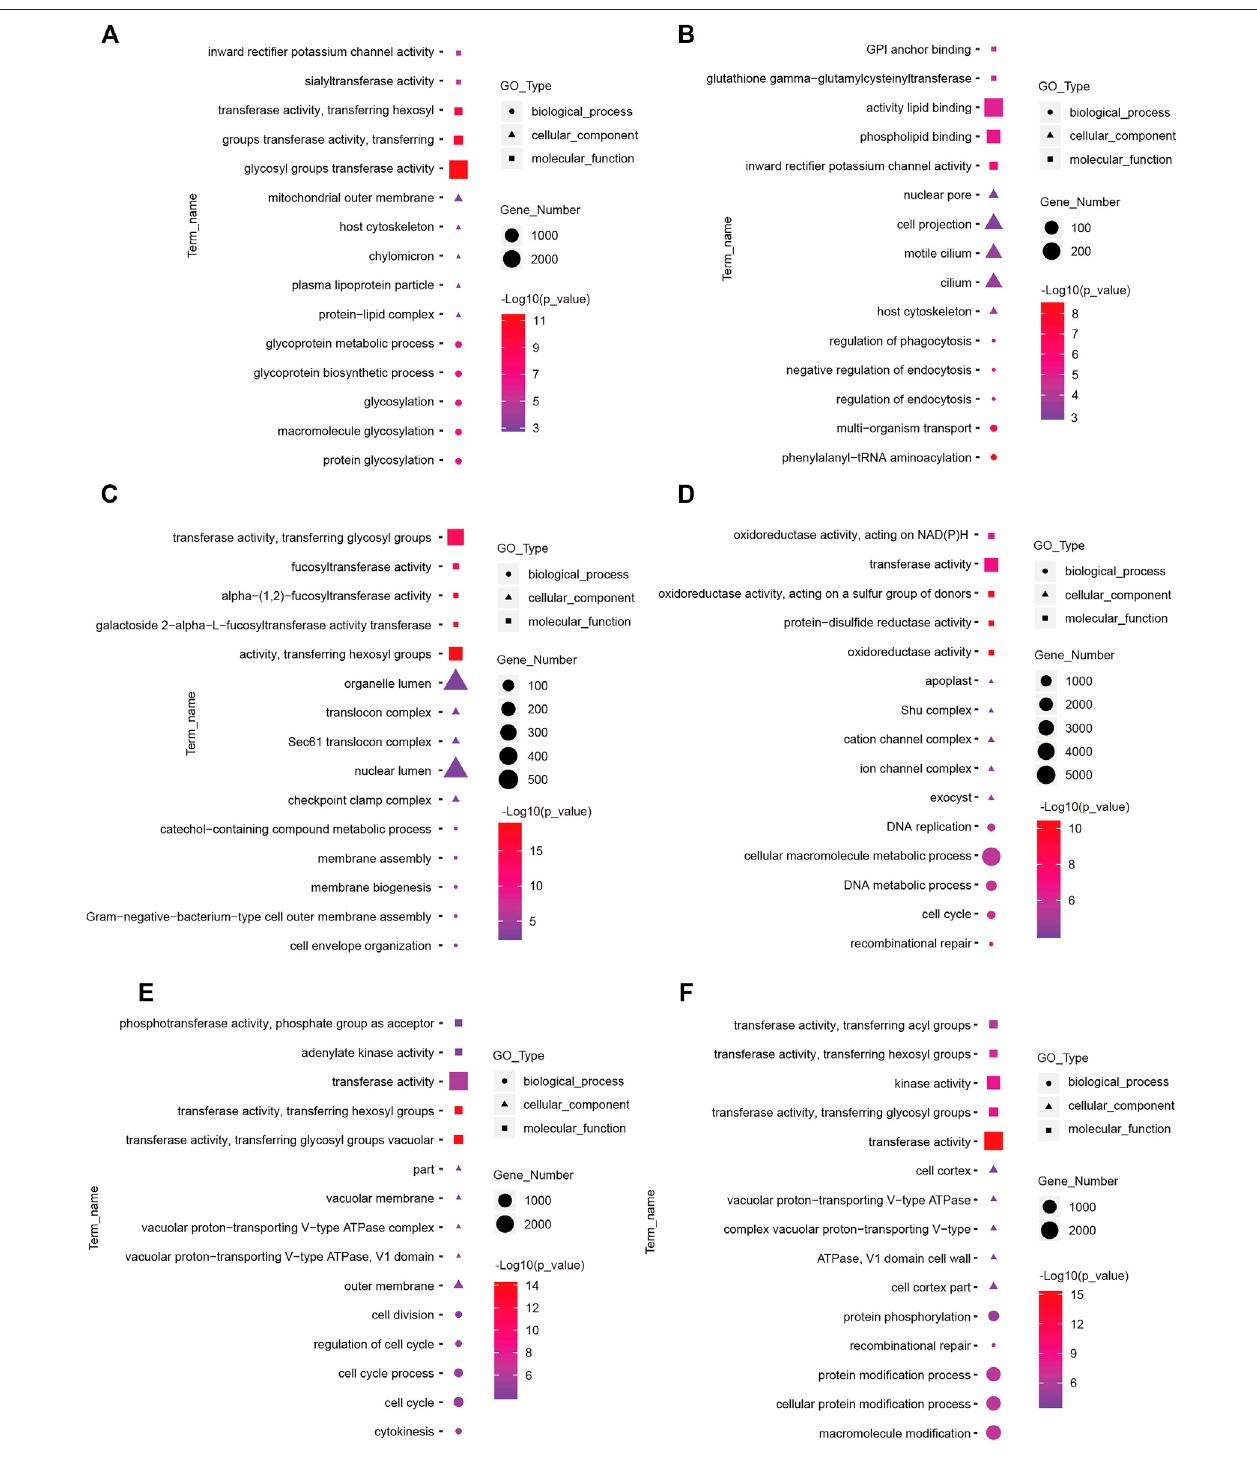
FIGURE6| TopenrichedGeneOntology(GO)termsofdifferentiallyexpressedlncRNAsbetweentheshortphotoperiodandlongphotoperiodinthehypothalamus of Sunite sheep. The GO terms in (A – F) are from SP42 vs. LP42, SP42 vs. SP-LP3, SP42 vs. SP-LP7, SP42 vs. SP-LP15, SP42 vs. SP-LP21, and SP42 vs. SP-LP42,